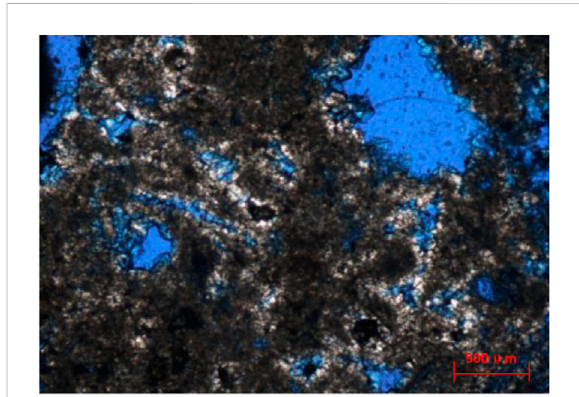
Petrological characteristics of shallow dolomite sample. Microcrystalline bioclastic dolomite at the top (288.91 m) of the second member of the Yinggehai Formation. The echinoderm bioclastic in the middle of the photo is completely dolomitized, with a diagonal length of 1.6 mm (1N).